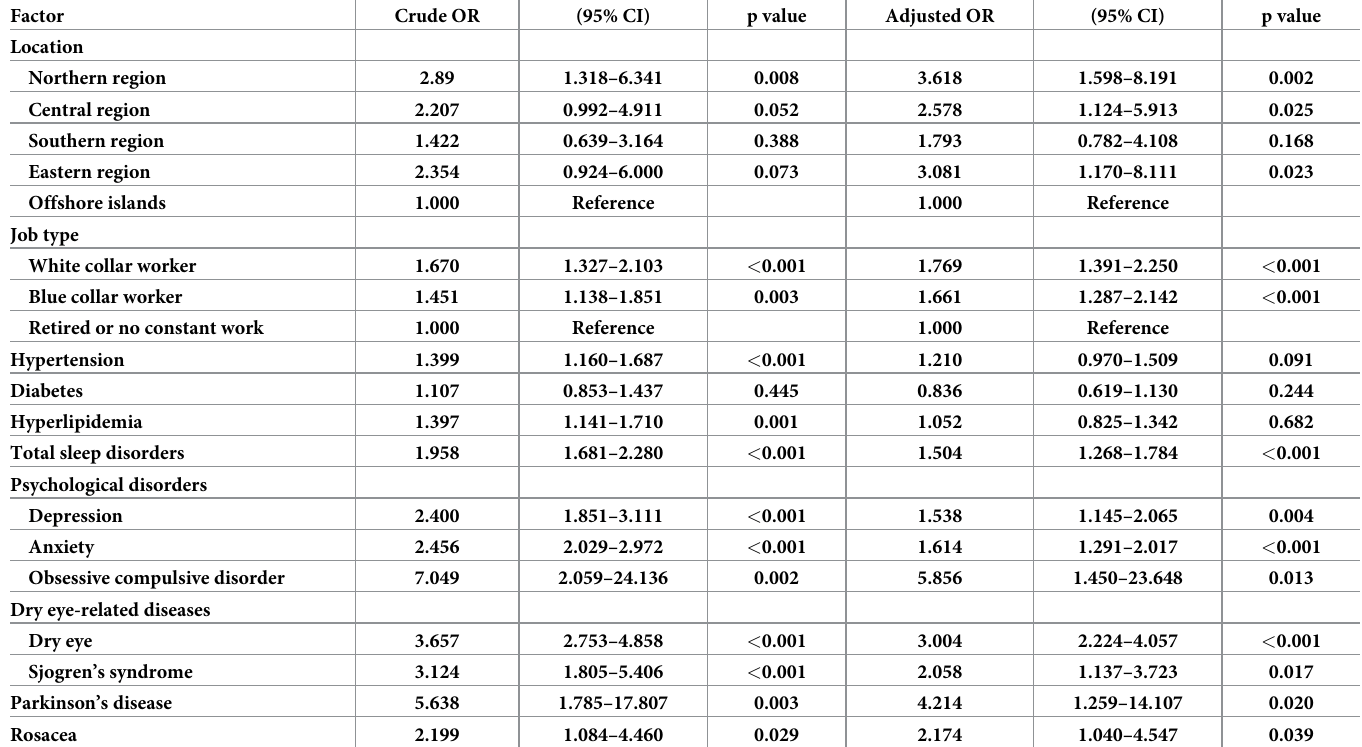
Table 5. Crude and adjusted odds ratios for benign essential blepharospasm among female cases and